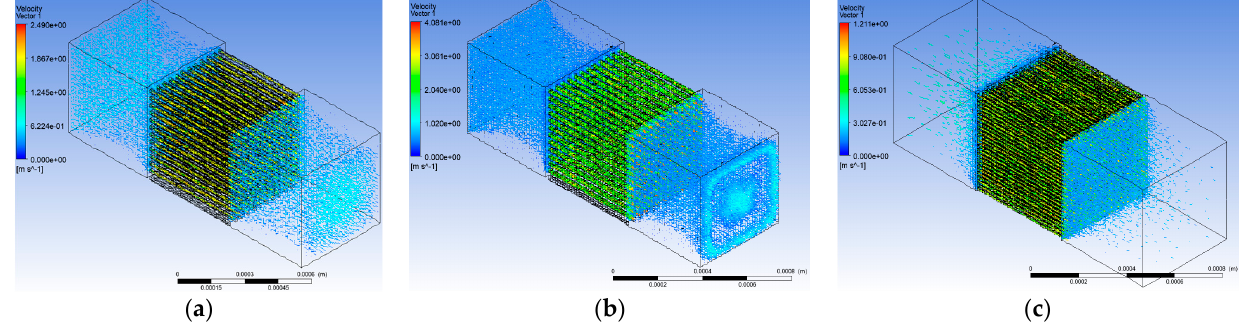
Figure 4. Air flow velocity vectorial solution in model of ( a ) case II, middle detalization; ( b ) case II, high detalization; and ( c ) case III: middle detalization of porous mycelium